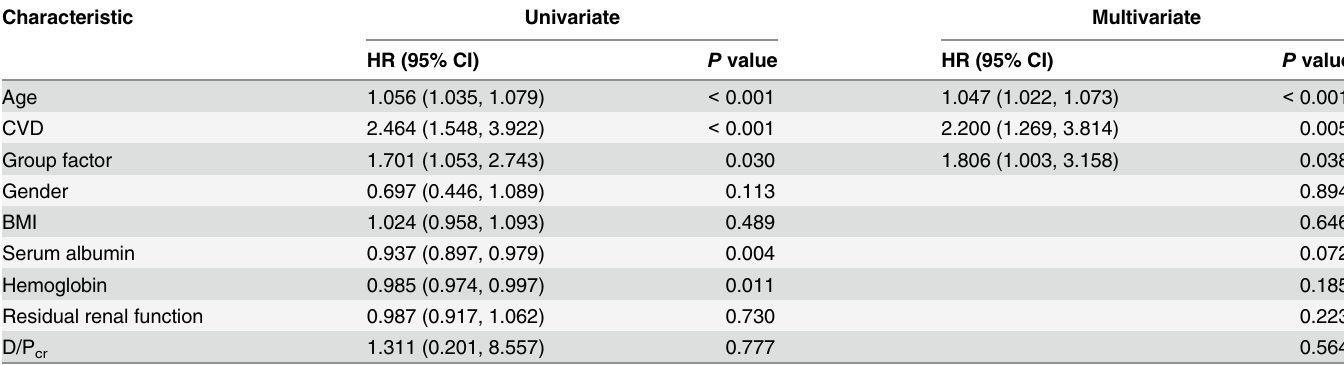
Table 5. Results of univariate and multivariate Cox analysis of patient survival in all diabetic peritoneal dialysis (PD) patients.